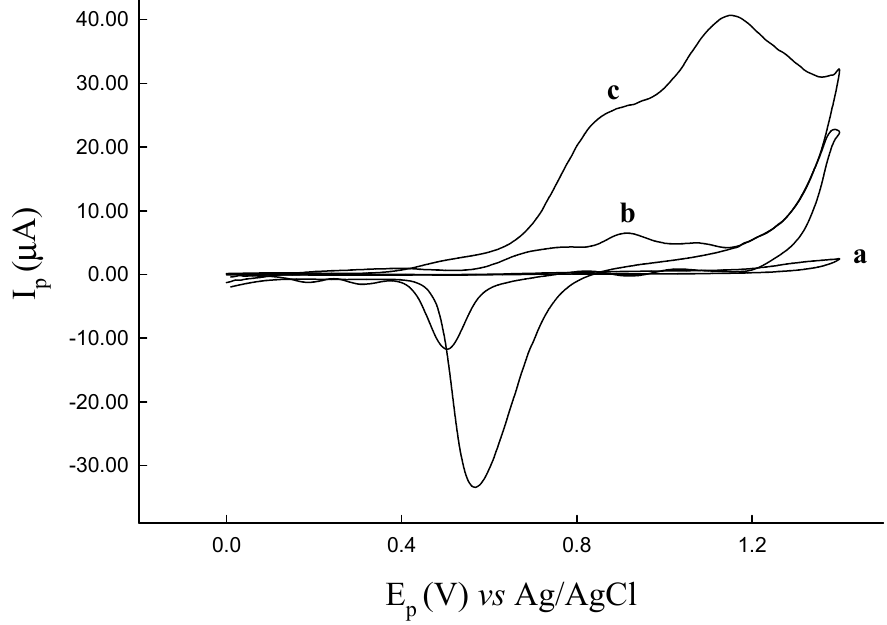
Figure 2. Cyclic voltammograms of cysteine (4 mg·L − 1 ) in Britton-Robinson buffer pH 4.86: ( a ) at the bare CFE; ( b ) at the bare Au (i.d. 3 mm); ( c ) at Au modified CFE. Scan rate at 10 mV/s.